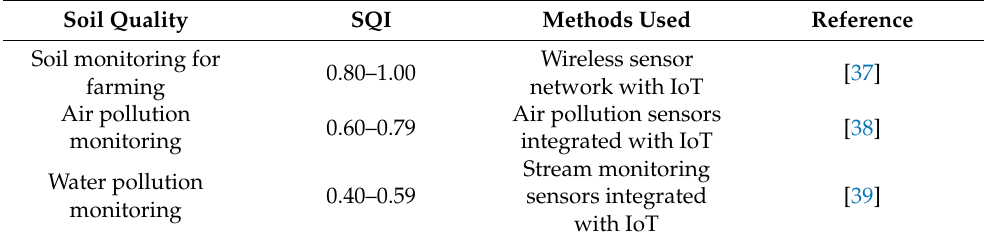
Table 4. Challenges with smart monitoring technologies using IoT